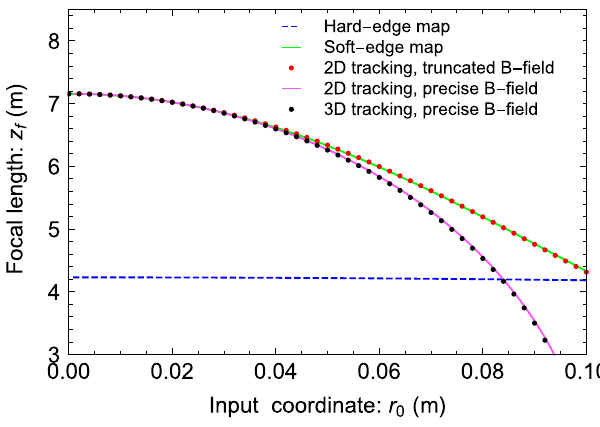
FIG. 3. Focal length as a function of input coordinate r 0 ¼ ffiffiffiffiffiffiffiffiffiffiffiffiffiffiffi p x 2 þ y 2 for protons with 10 MeV energy. Two lower matching curves show 2D (5) and 3D (1) simulations in case of precisely defined magnetic field of the current loop [17]. Two upper matching curves are for 2D simulations (5) with truncated magnetic field and for the nonlinear soft-edge transfer maps (22), (28), (29) derived from this 2D equation. The single horizontal blue dashed line represents the hard- edge model (26) that is equivalent to the soft-edge model with m 1 ¼ m 2 ¼ p 0 ¼ s 0 ¼ 0